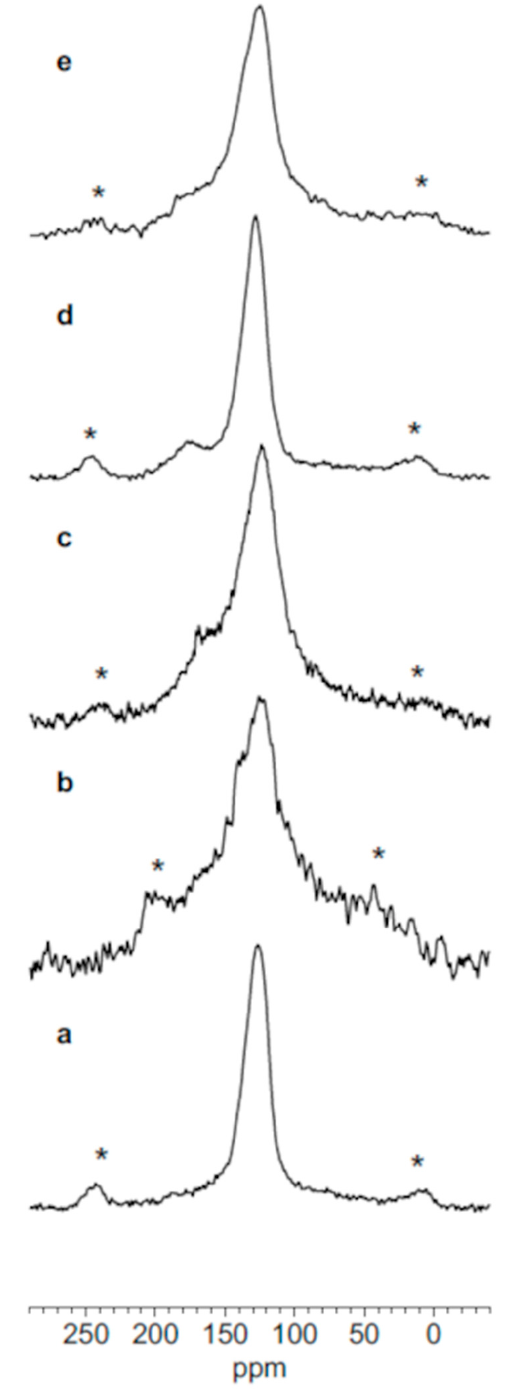
Figure 5. 13 C SPE MAS spectra of wB ( a ), wAC ( b ), pB ( c ), pAC_meso ( d ), and pAC_micro ( e ). Sidebands are marked with asterisks.